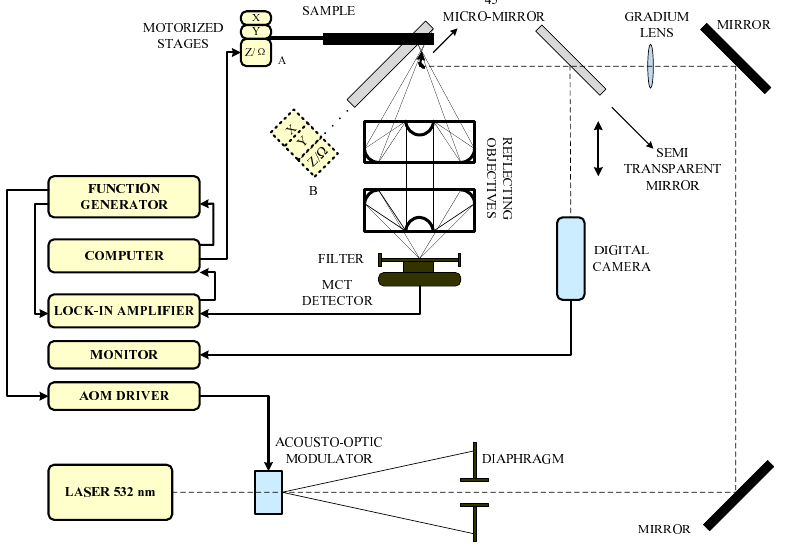
Figure 23. Schematic of the experimental system for photothermal radiometry of subsurface hairline manufacturing